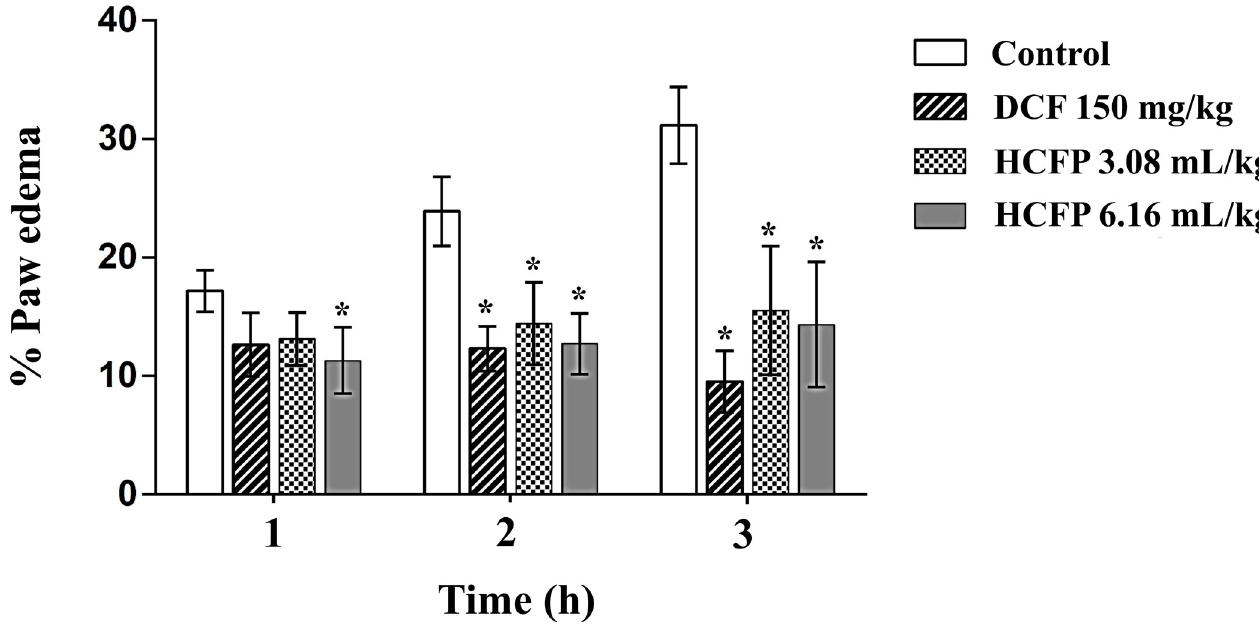
Fig 5. Effect of HCFP and DCF on carrageenan-induced paw edema in Wistar rats. Bar graphs show percentages of changes in paw edema. Data are expressed as mean ± SD of n = 6 rats/group. Asterisk “ � ” indicates a significant difference at p < 0.05 as compared with the control group.